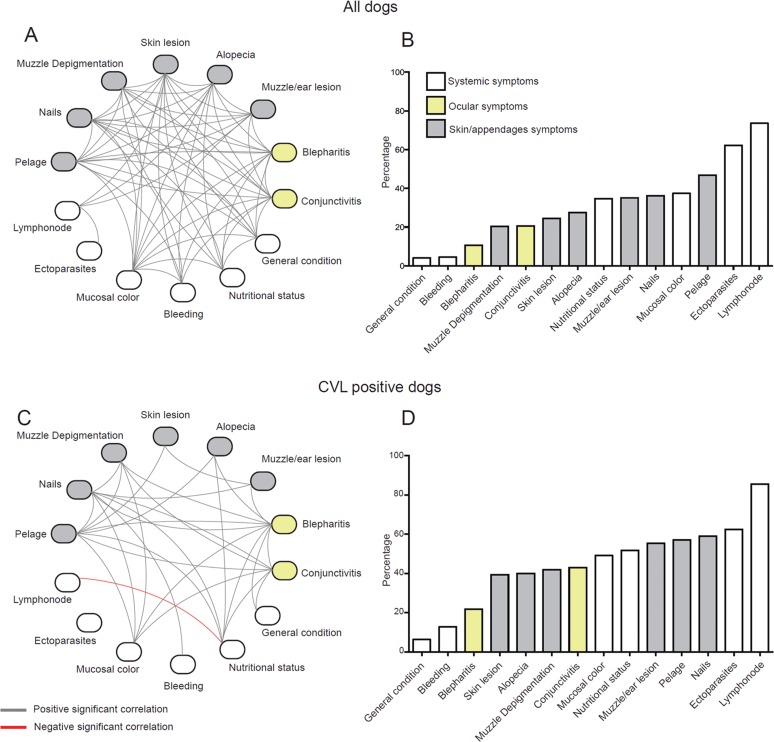
: networking the clinical signs of dogs with canine visceral leishmaniasis (CVL). The network analysis (interactome) shows statistically significant correlations (p < 0.05) between all the signs recorded for all sick dogs (A) and CVL-positive dogs (C). Data were analysed using Spearman rank tests. Yellow-coloured items are ocular signs, grey icons are skin/appendage signs, and white entries are systemic signs. Grey and red lines represent significant positive and negative correlations, respectively. The percentages of positivity for each sign are illustrated for all dogs (B) and CVL-positive dogs (D).